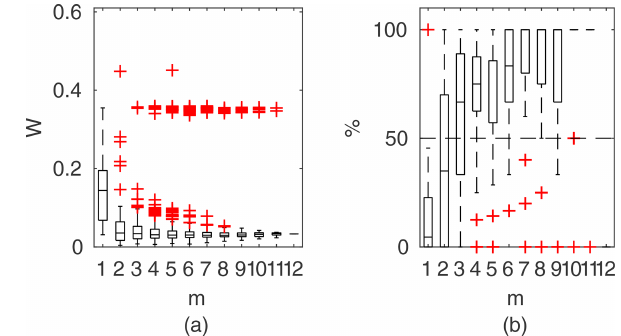
Figure B14. PTLM results for the Ritobacken case study, spring 2011: (a) averaged relative confidence widths W as a func- tion of observation set size m used for model identification; (b) per- centage of verification points enclosed by the confidence inter- vals (100% denotes all points within intervals, box spans over the 25% and 75% quantiles, the median is given with horizontal line, whiskers indicate the result extent, and cross marks are for extreme values).